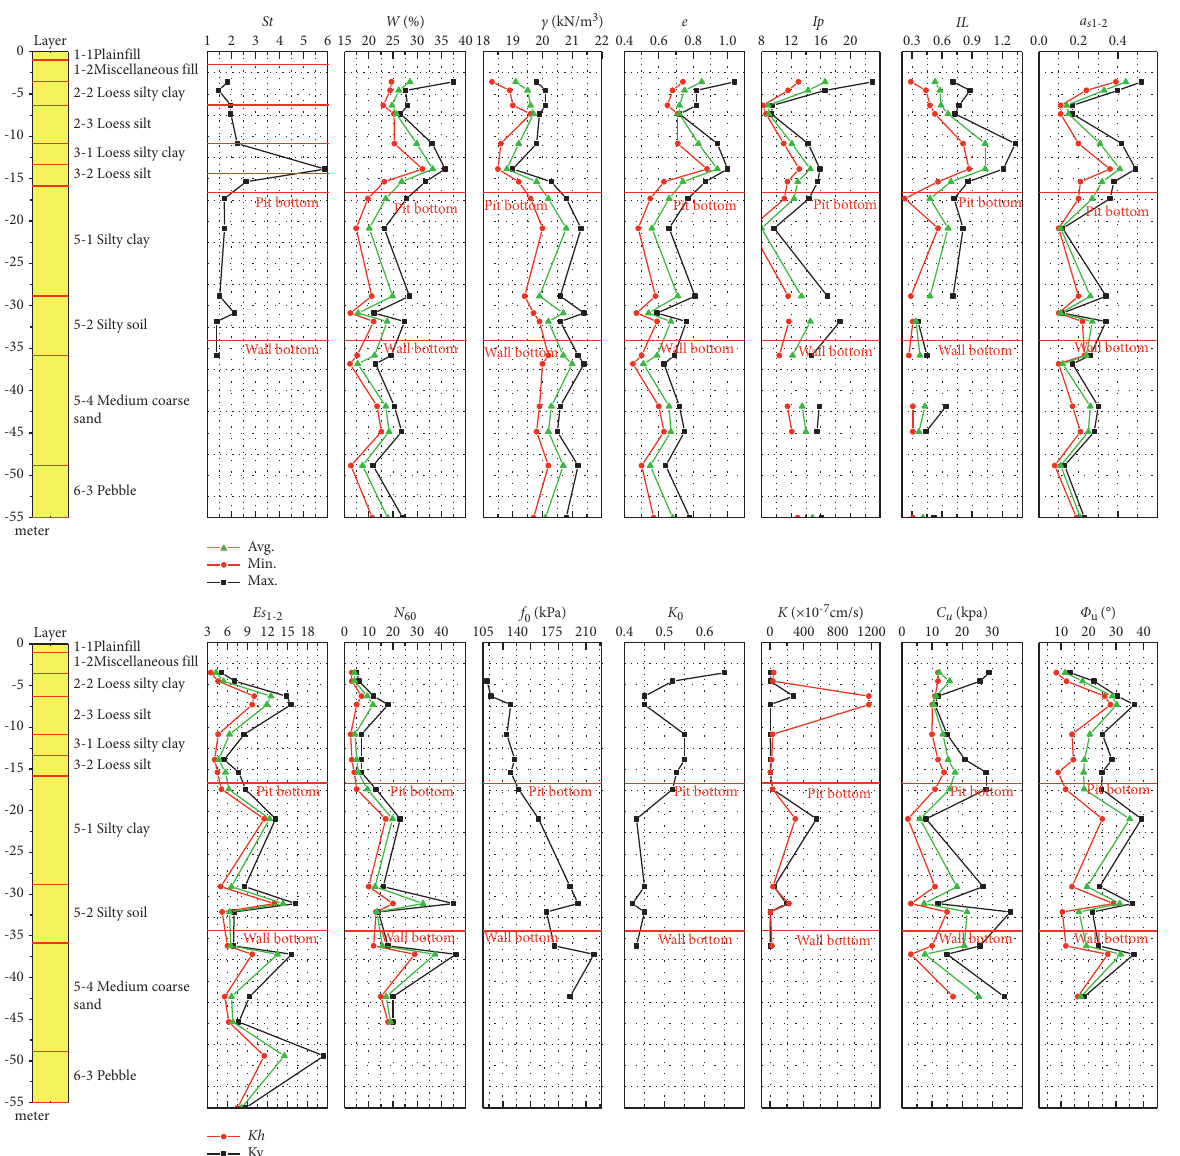
Figure 6: Physical and mechanical properties of soil